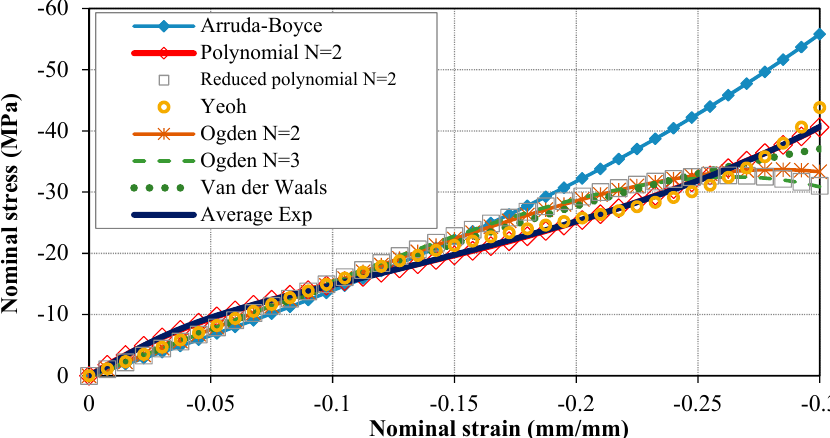
Figure 6. The resultant stress–strain curves that fitted using the hyperelastic models provided in Table 2.